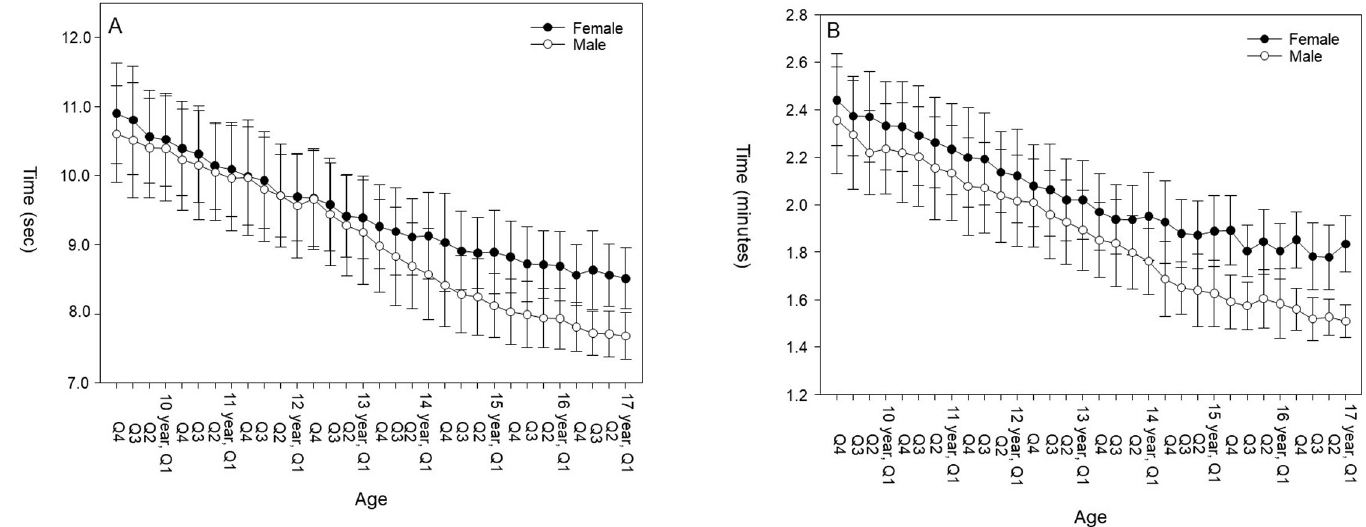
Fig 1. Mean of best indoor running times on 60-meter sprint (A) and 600-meter middle-distance running (B) for different age groups in male and female track and field athletes from 2011–2020. Q1: born in January-March, Q2: born April-June, Q3: born in July-September, Q4: born in October-December.